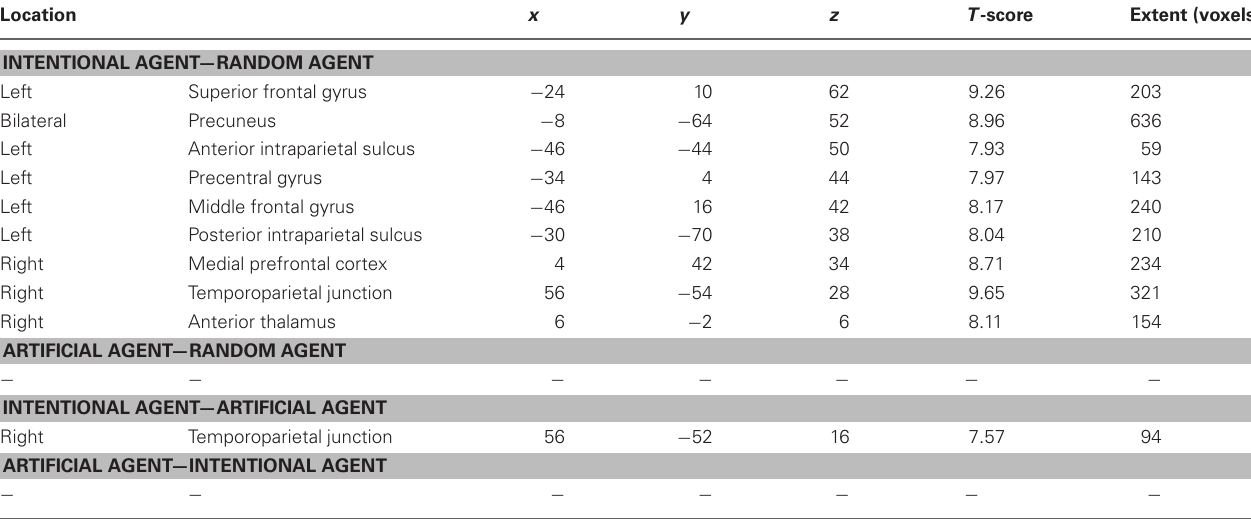
Table 1 | Regions of increased BOLD response in comparisons between believing the Rock-Paper-Scissors game is being played against an intentional agent (Int), an artificial agent (Art), and a random number generator (Rnd).